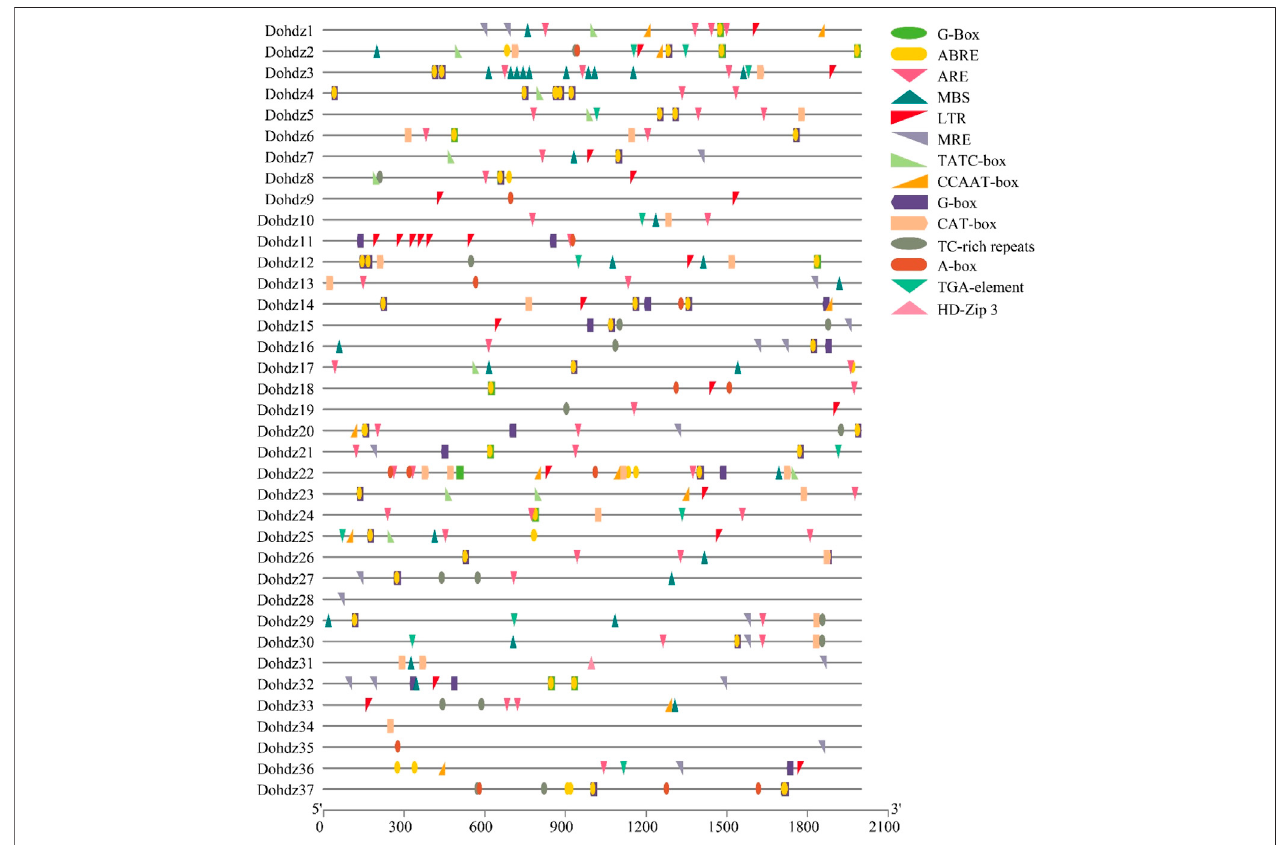
FIGURE 3 | Cis -elements found in the promoter regions of these 37 HD-ZIP genes in D. of fi cinale.